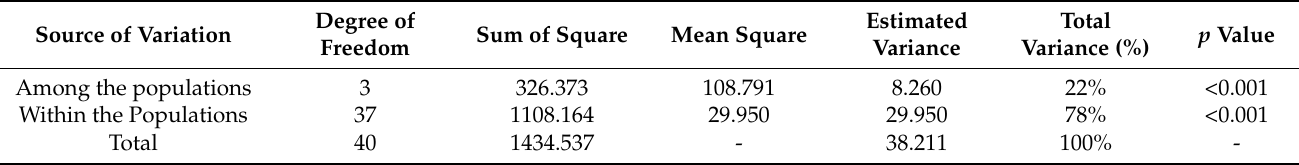
Estimated Total p Value Variance Variance (%)